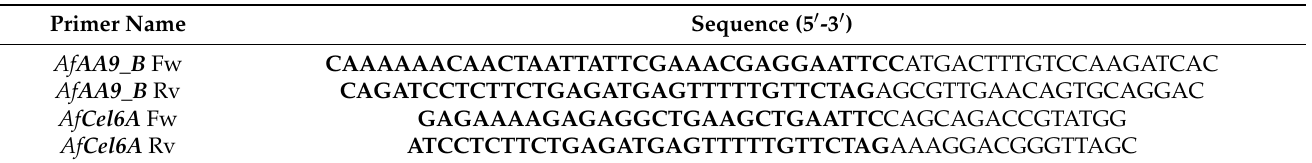
Table 5. Primer sequences used to amplify and to clone